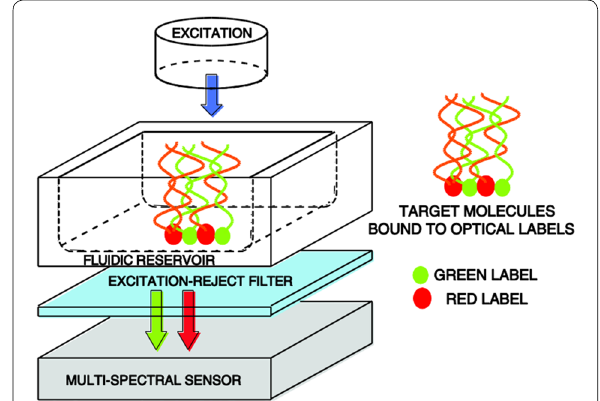
Fig. 8 Contact CMOS fluorescent imaging system set up (repro‑ duced from [84], published by MDPI in open access)